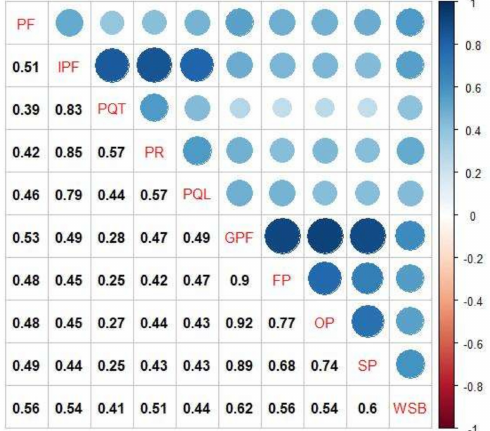
Figure 1. Correlation coe ffi cient matrix of each variable (N = 1505). Note: PF indicates product facilities, IPF indicates individual preference framework, PQT indicates preferences for quantity, PR indicates preferences for rhythm, PQL indicates preferences for quality, GPF indicates group preference framework, FP indicates family preference, OP indicates organizational preference, SP indicates social preference, WSB indicates waste-sorting